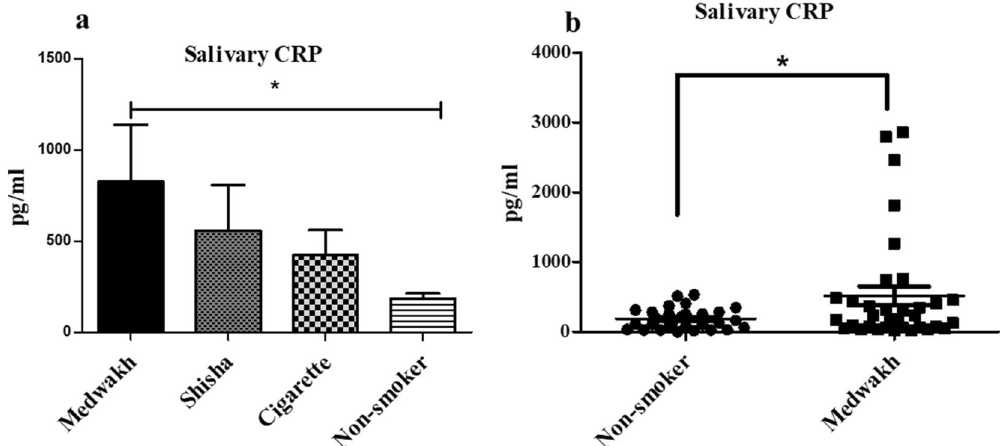
Figure 7. The salivary levels of C reactive protein (CRP) as an indicator of inflammation among users of different types of tobacco. ( a ) The levels of CRP among users of medwakh, shisha, and cigarettes in comparison with non-smoking controls in the pilot study. Saliva samples of medwakh smokers showed the highest level of CRP among other smokers with a significant difference compared to non-smokers (* p < 0.05). ( b ) Scatter plots showing the distribution of CRP levels in 30 medwakh smokers in comparison with 30 non-smokers. * p < 0.05 is